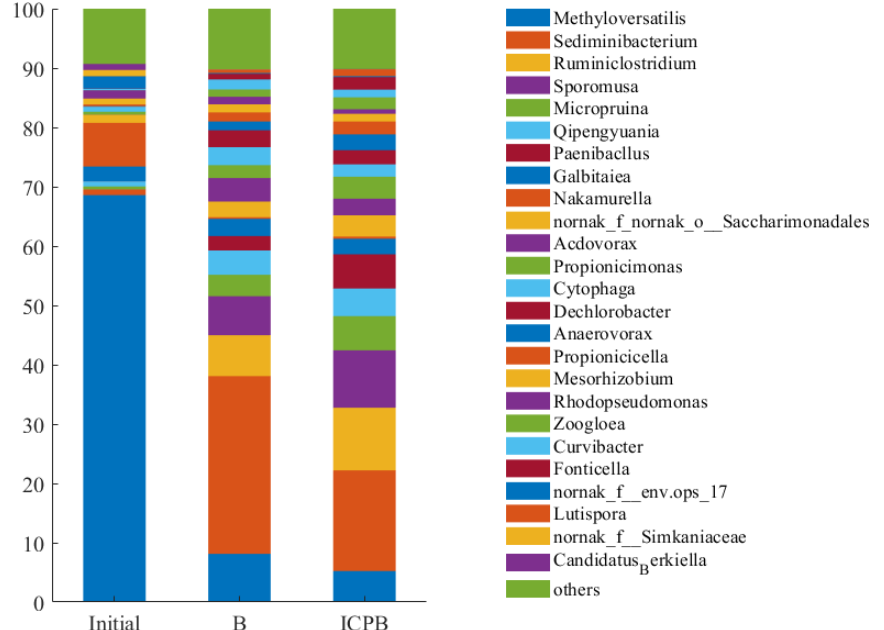
Figure 10. Composition of microbial communities at genus level in samples of initial, B, and ICPB. Initial—the sample before the reaction; B and ICPB—the samples of the biodegradation and coupling, respectively.